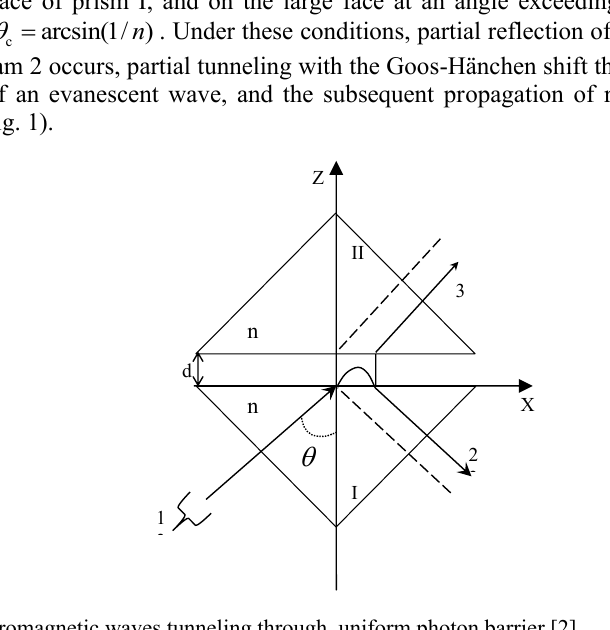
Fig. 1. Electromagnetic waves tunneling through uniform photon barrier